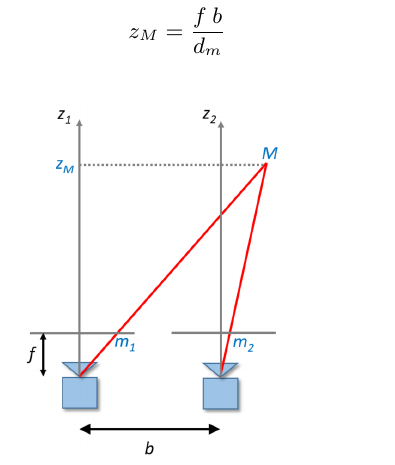
Figure 4. Stereo-vision with normalized images. Given the depth computation expressed as in (1) and the point matching resolution, done at pixel level in this work, it is clear that the quite small baseline between the two images is a severe limiting factor in the depth estimation. This aspect is analyzed in Fig. 5 , where depth is shown as a function of the disparity: being the matching done at pixel level, only integer values of the disparity have been considered.